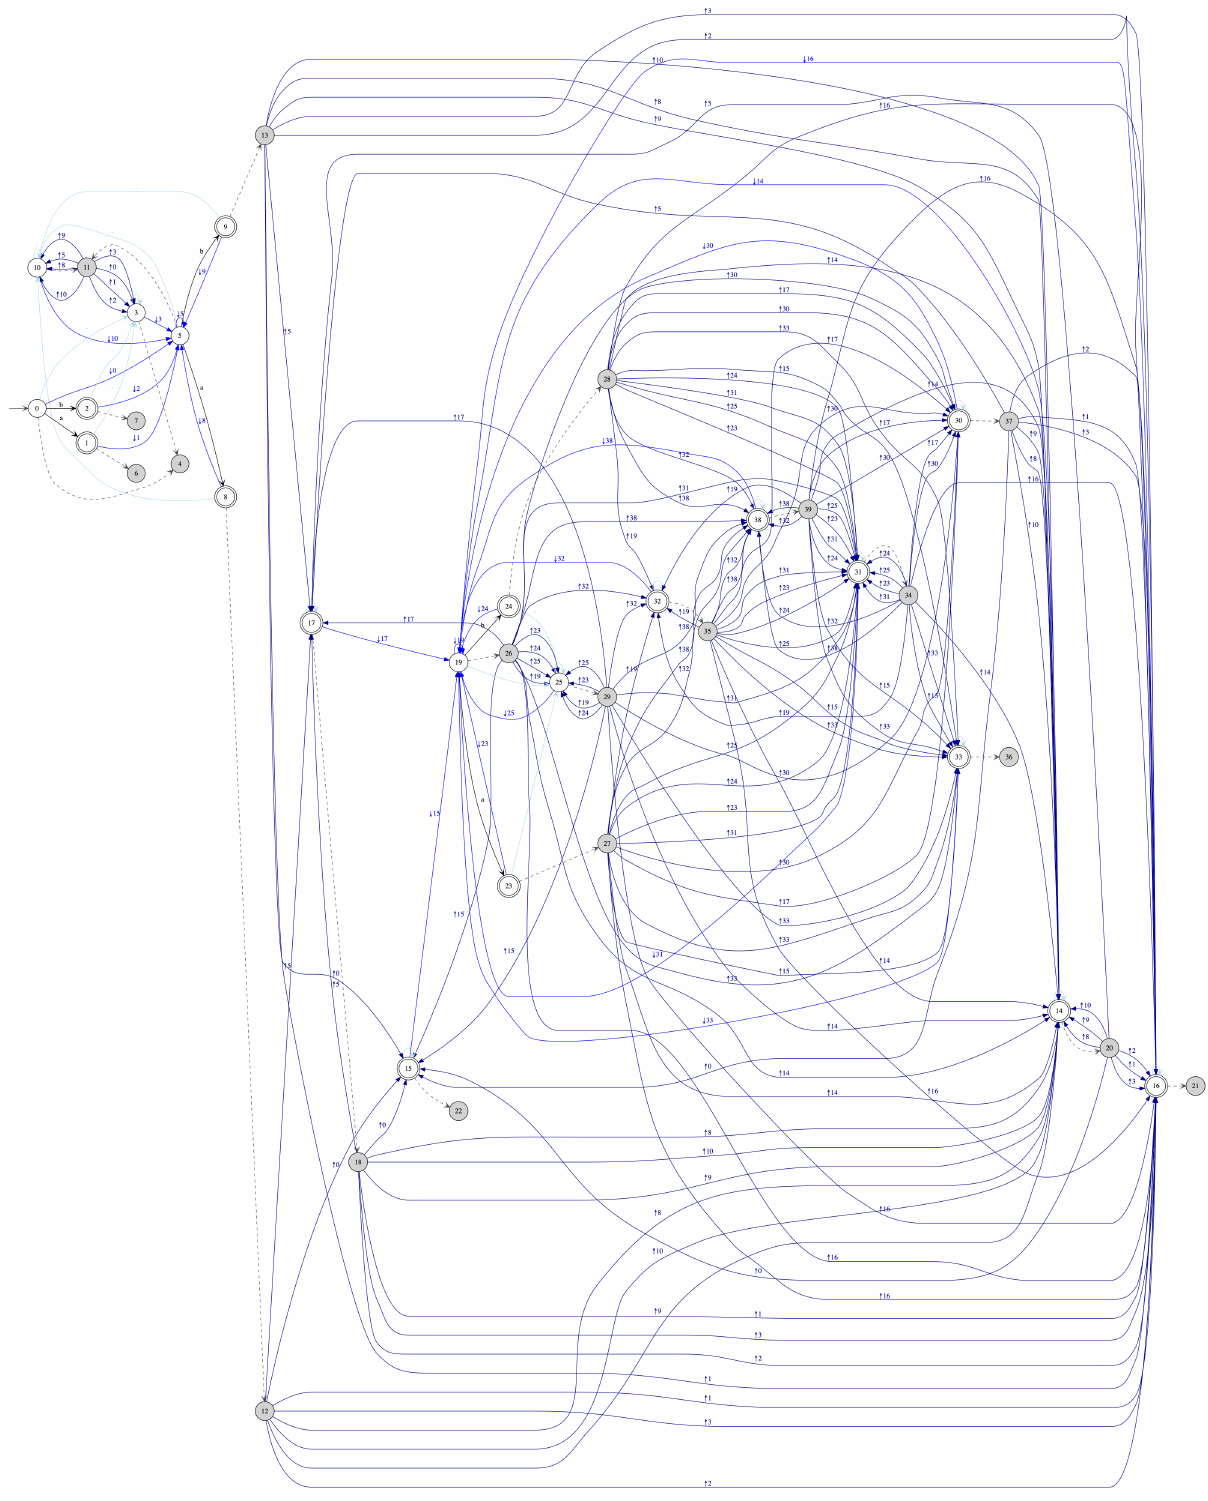
Figure A2. Deterministic NWA : det ( nwa ( ch ∗ ( a + b ))